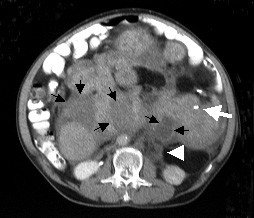
Abdominal CT image of slightly more distal of figure 3 shows multiple, homogenous or central necrotic (black arrows) or calcific (white arrow) masses invaded to the small bowel mesentery and left ureter (arrowhead).